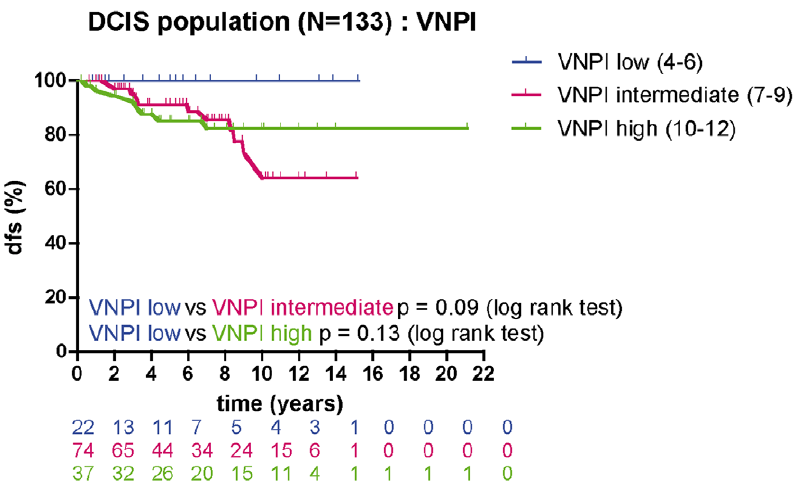
Figure 3. VNPI and clinical outcome: Disease-free survival analysis for patients with DCIS (N=133) according to VNPI risk group.